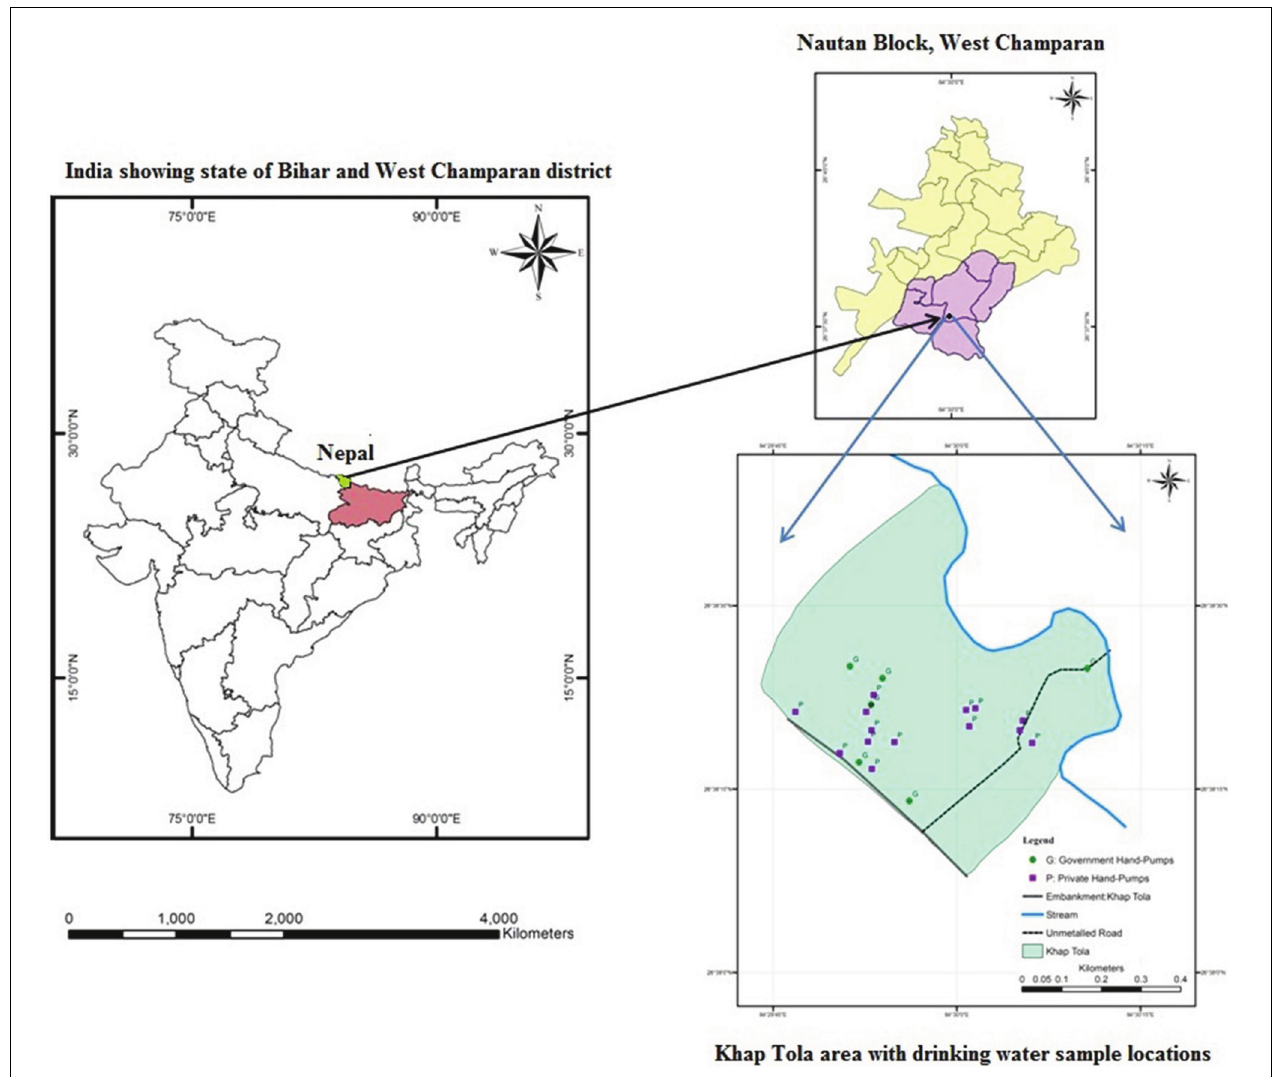
FIGURE 1 | Map of study area showing the location of Khap Tola with drinking water sample locations. Khap Tola lies in Nautan block in West Champaran district, which is shown in the map. P and G denote Private and Government hand-pumps